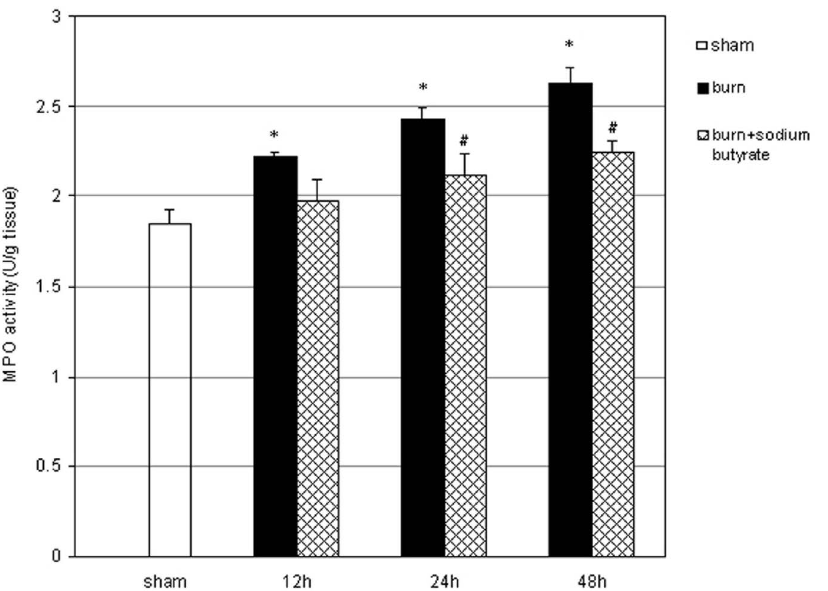
Figure 6. Effect of sodium butyrate on MPO activity in lung tissues. Pulmonary MPO activity started to increase gradually at 12 h after burn injury, which was markedly attenuated by sodium butyrate treatment. Results are given as mean 6 SEM (n=8). *p , 0.05, vs. sham, ANOVA; # p , 0.05, vs. related burn group, ANOVA.